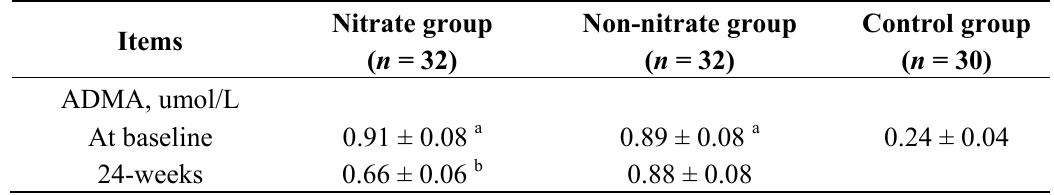
Table 4. ADMA Levels in CAPD Patients and controls.